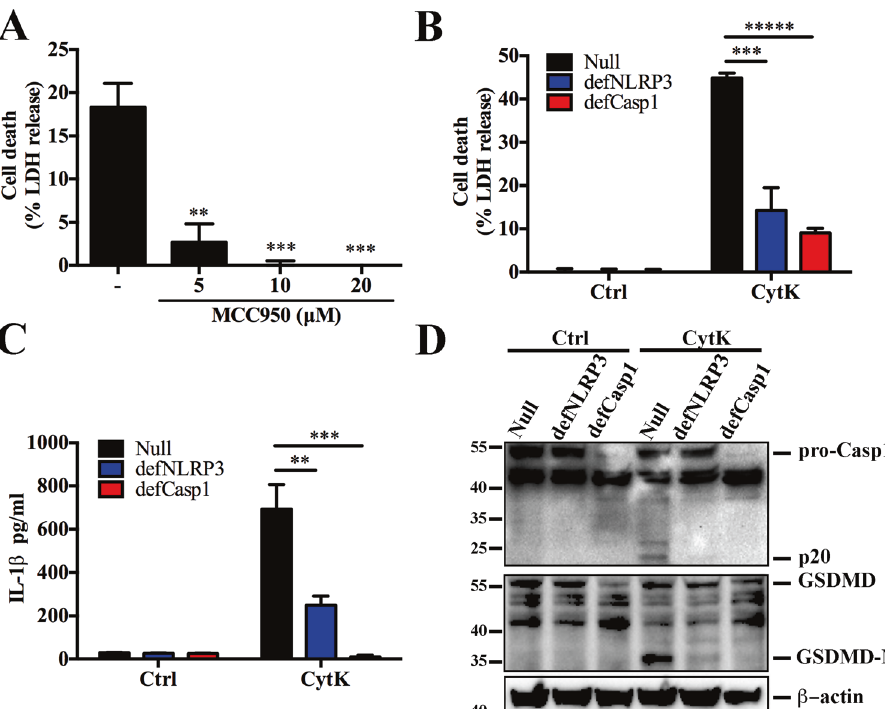
Fig. 3 NLRP3 is required for CytK-induced pyroptosis. A dTHP-1 cells were pretreated with or without ( − ) different concentrations of MCC950 for 1 h and then treated with CytK for 1 h. Cell death represented by LDH release was determined. ( B – D ) PMA-differentiated THP-1- null, -defCasp1 ( Casp1 knockdown), and -defNLRP3 ( Nlrp3 knockdown) cells were treated with or without (Control, Ctrl) CytK for 1 h. LDH ( B ) and IL-1 β ( C ) in the supernatants of the cells were determined. The supernatant together with the corresponding cell lysate were blotted with antibodies against Casp1, GSDMD, or β -actin (loading control) ( D ). For panels A – C , data were the means of triplicate assays and shown as means ± SD. ** p < 0.01; *** p < 0.001; ***** p < 0.00001; one-way ANOVA with Dunnett ’ s multiple-comparison